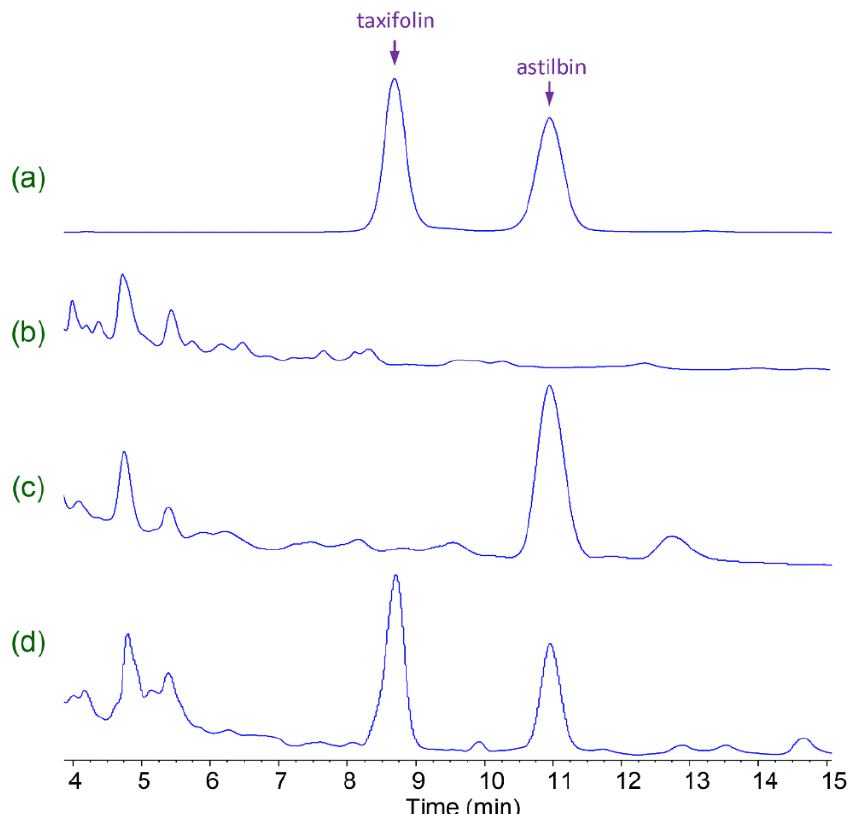
Figure 2. High-performance liquid chromatography (HPLC) analysis of taxifolin and astilbin. ( a ) Standard taxifolin and astilbin dissolved in methanol; ( b ) Extract of SQH4 culture medium without added astilbin; ( c ) Extract of SQH2 culture medium, after incubation with 1 g/L astilbin; ( d ) Extract of SQH4 culture medium, after incubation with 1 g/L astilbin. Biotransformation was performed at 30 °C, pH 4.5, shaking at 200 r/min for 8 h.